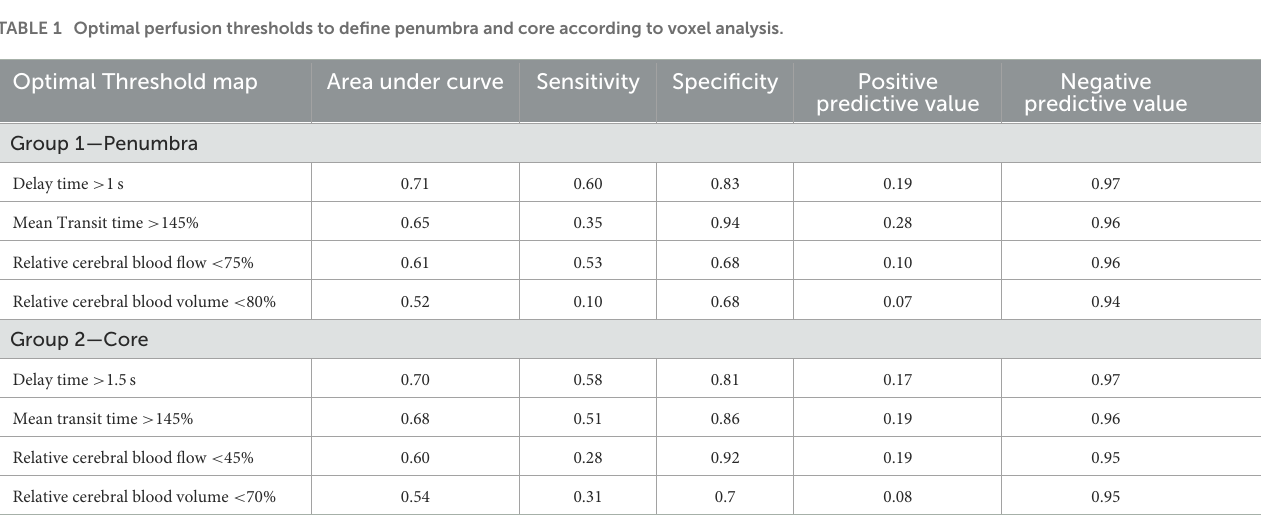
TABLE 1 Optimal perfusion thresholds to define penumbra and core according to voxel analysis. Optimal Threshold map Area under curve Sensitivity Specificity Positive